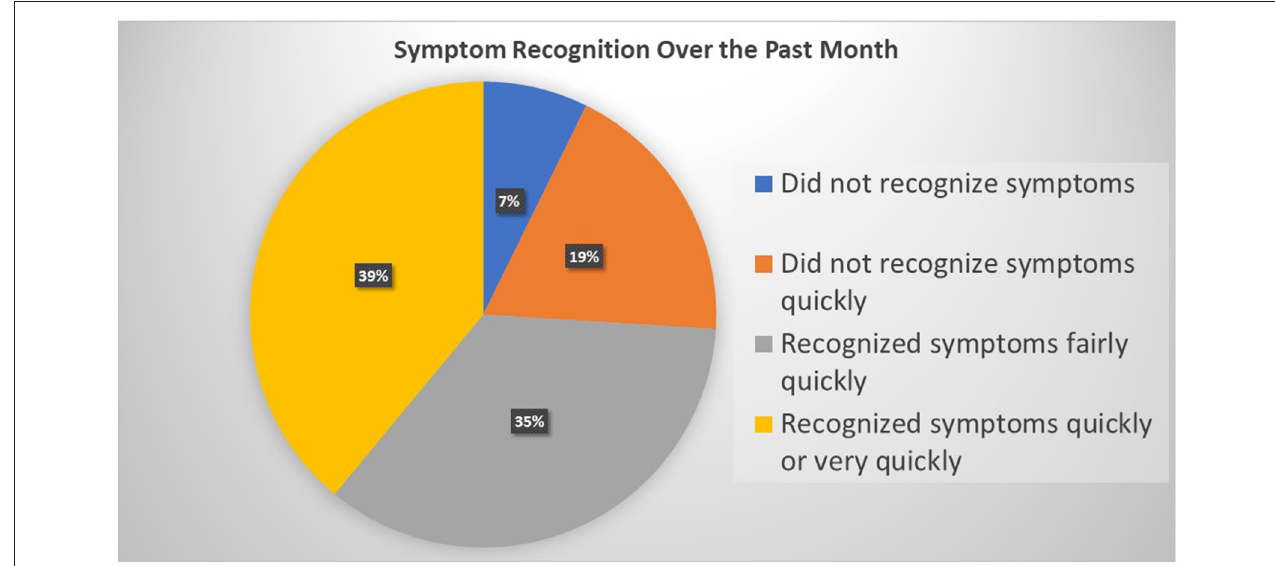
FIGURE 2 | Graphic illustration of the way responses to this question can be